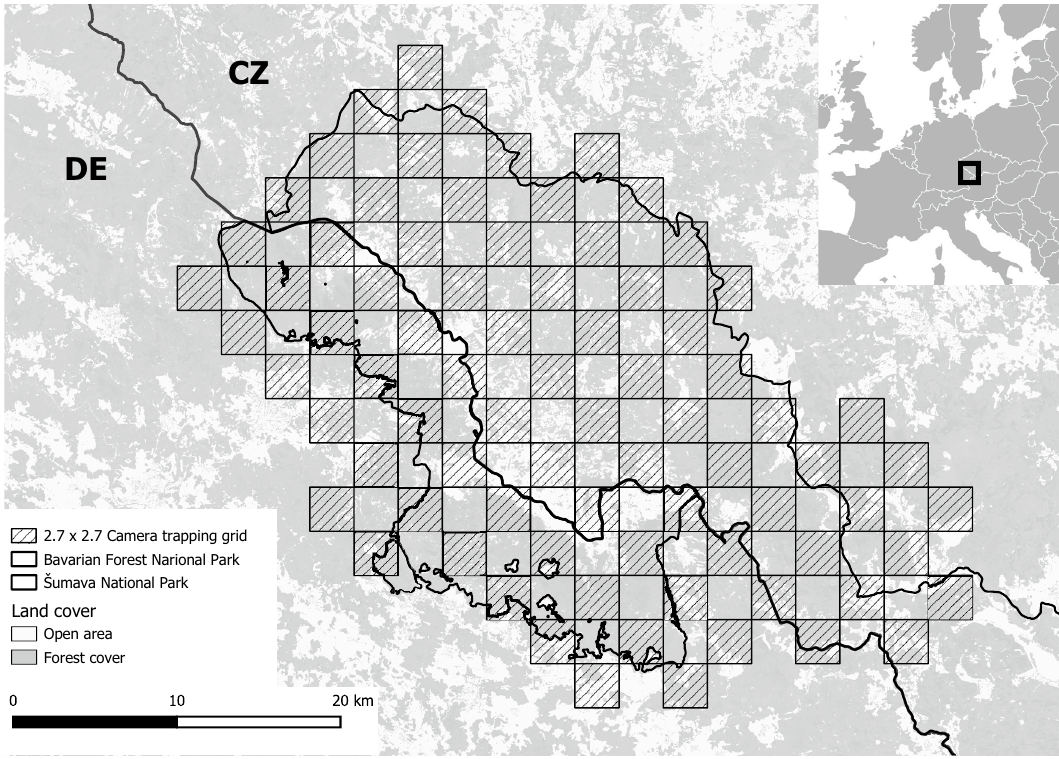
Figure 1. Map of the study area with forest coverage including the Bavarian Forest National Park (BFNP) on the German side (DE), the Šumava National Park (SNP) on the Czech side (CZ) and the 2.7 × 2.7 km camera trapping grid in which sites were located in every second cell. The map was created using QGIS 3.4 https:// qgis. org/ it/